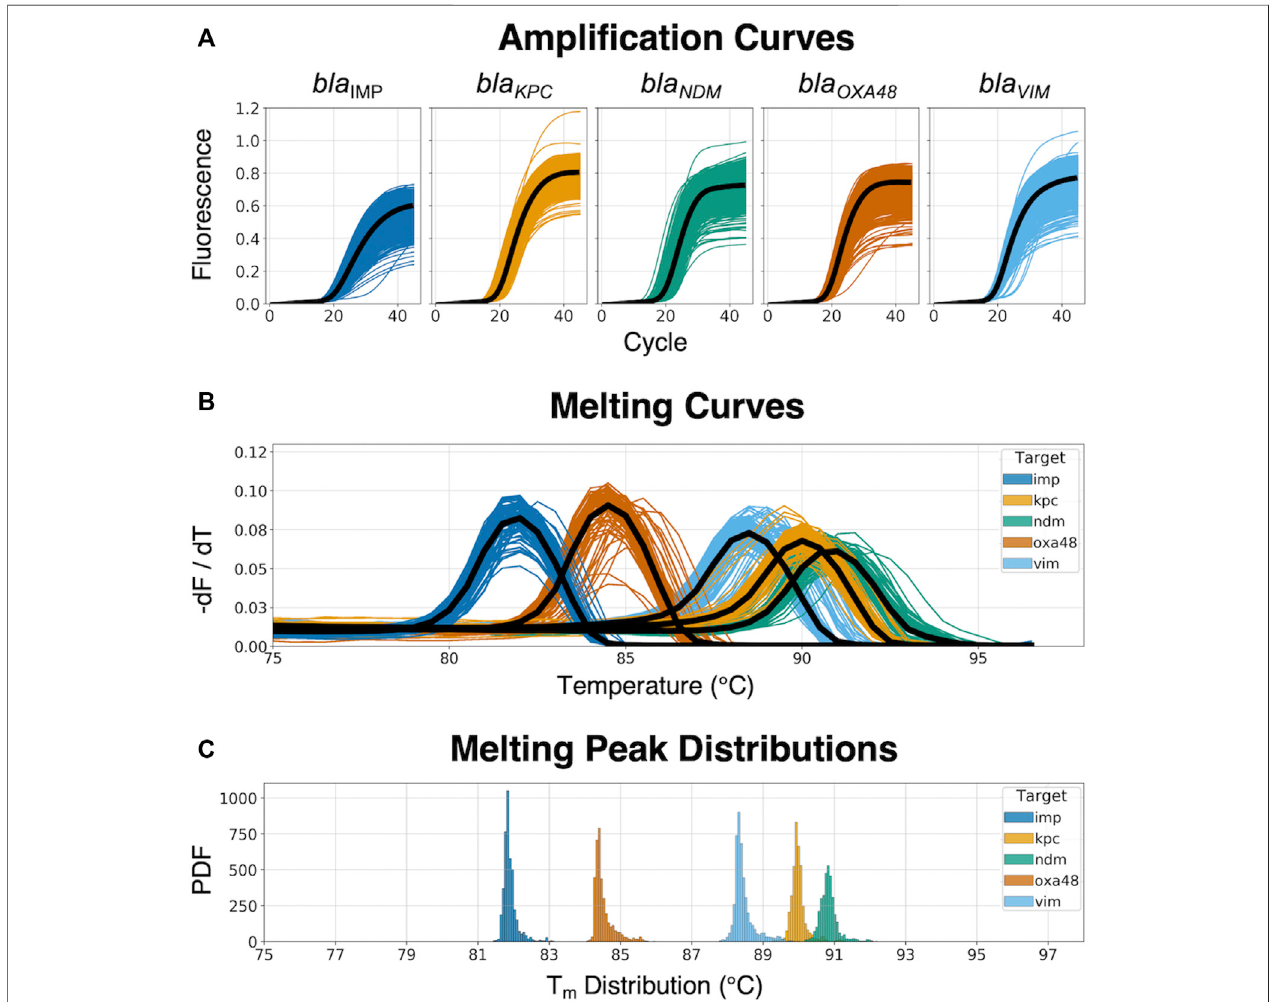
FIGURE3| Real-timeampli fi cationandmeltingcurvesobtained fromthedPCR instrument. (A) Rawampli fi cationcurvesatdifferentconcentrationsfromsynthetic DNA templates; the black line represents the average trend of the kinetic information based on each speci fi c target-primer interaction. (B) Melting curves across the fi ve different CPO; the black line represents the average trend of the thermodynamic information based on each speci fi c target-primer interaction. (C) Melting peak (T m ) distribution from the dPCR instrument, showing the probability density function (PDF) for each target.